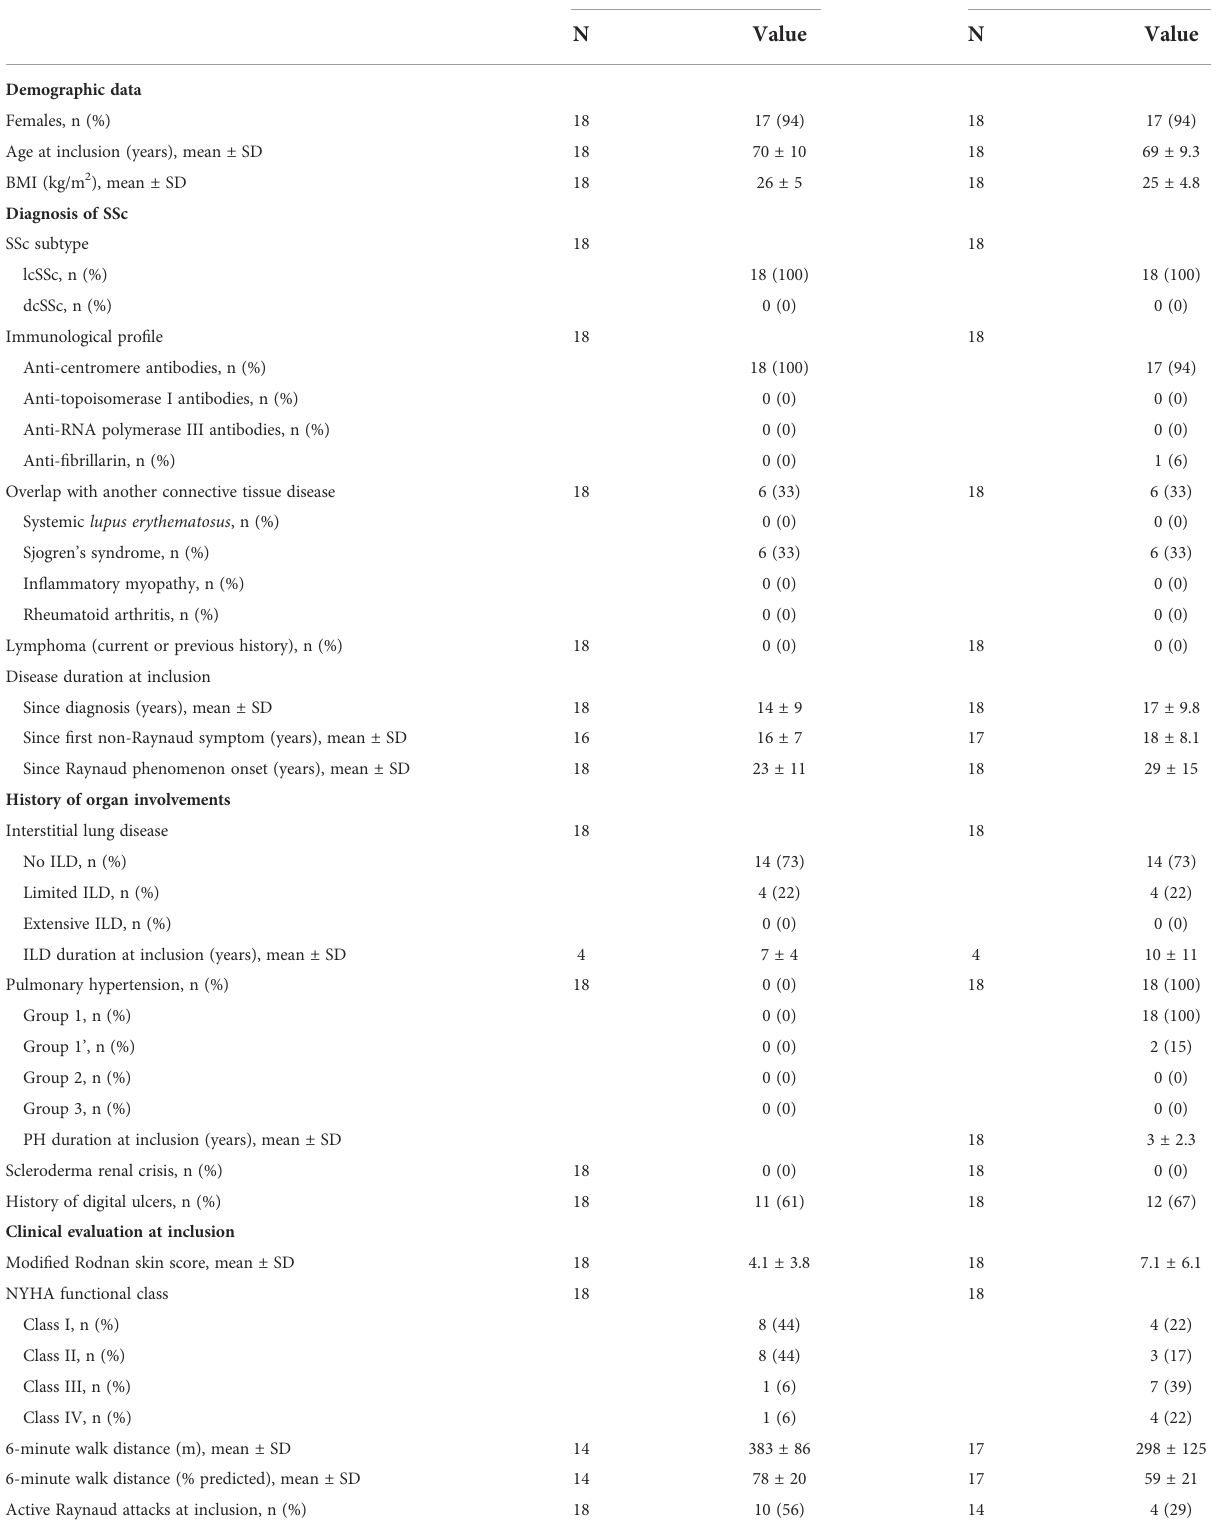
TABLE 4 Characteristics of SSc-PAH and SSc-no PAH patients from the validation